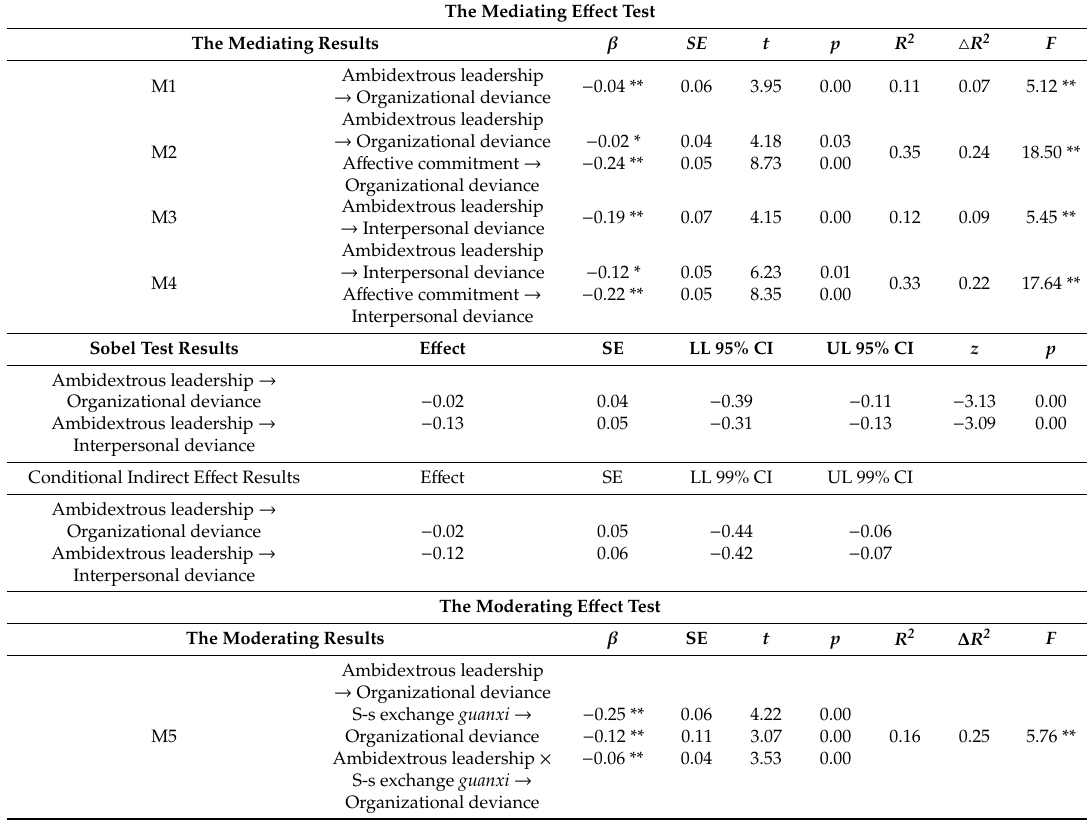
Table 3. The process analysis results of hierarchical regression and conditional e ff ect